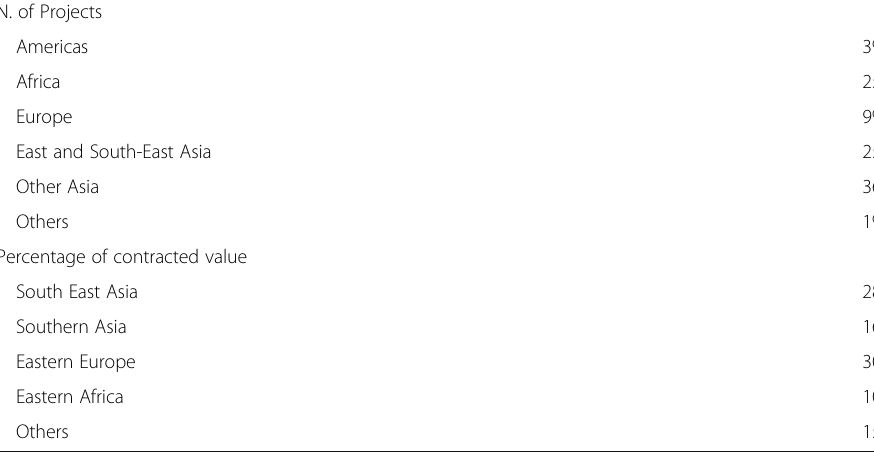
Table 2 ongoing Transport BRI projects N. of